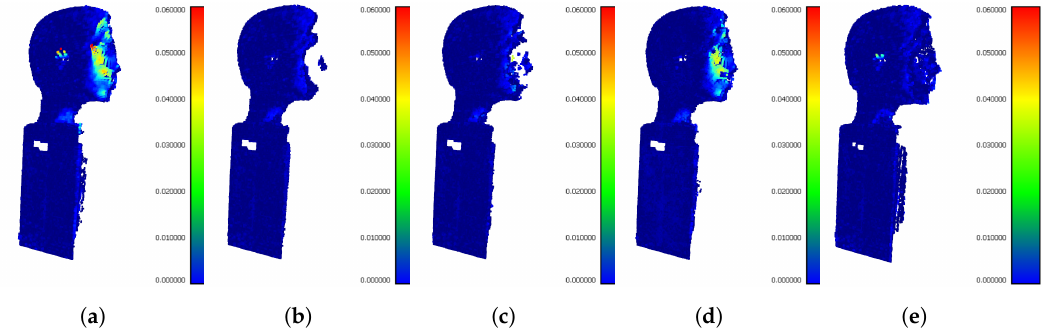
Figure 14. The comprehensive comparison of filtration methods using visualization of distances between filtered clouds and reference mesh. All the results are for buffer size 5. ( a ) The input point cloud without interference suppression. ( b ) The best result using SOR filter with parameters sdm 1.5 and k 100. ( c ) The best result using ROR filter with parameters rad 0.004 and pts 10. ( d ) The best result using PointCleanNet for buffer size 6. ( e ) The best result using our IMBM filter. Table 4. Importance Map Based Median (IMBM) filter best results for multiple buffer sizes.